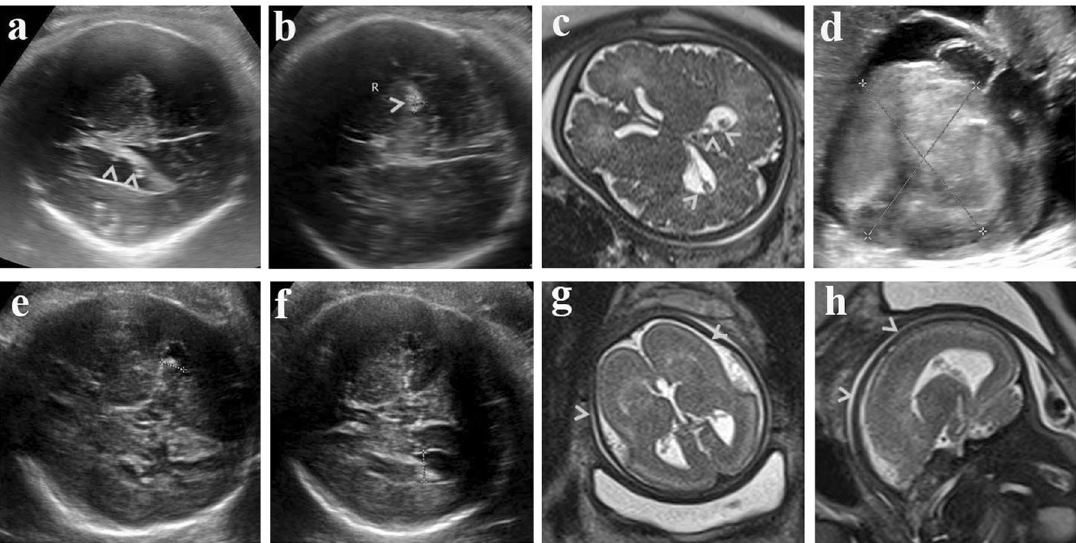
Fig. 4 Prenatal imaging of two typical cases, P221 (top row) and P796 (bottom row). Sonographic hyperechoic lesions in a cerebral lateral ventricles and b brain parenchyma indicated by arrows. c Hypointensity lesions revealed by T2-weighted MRI in cerebral lateral ventricles indicated by arrows. d Large space-occupying lesion in left ventricle shown by d sonography. Widths of the cerebral ventricle of P796 were 0.84 cm on left ( e ) and 1.04 cm on right ( f ) shown by sonography. g Coronal and h sagittal view of T2 MRI showing abnormal cortical gyration indicated by